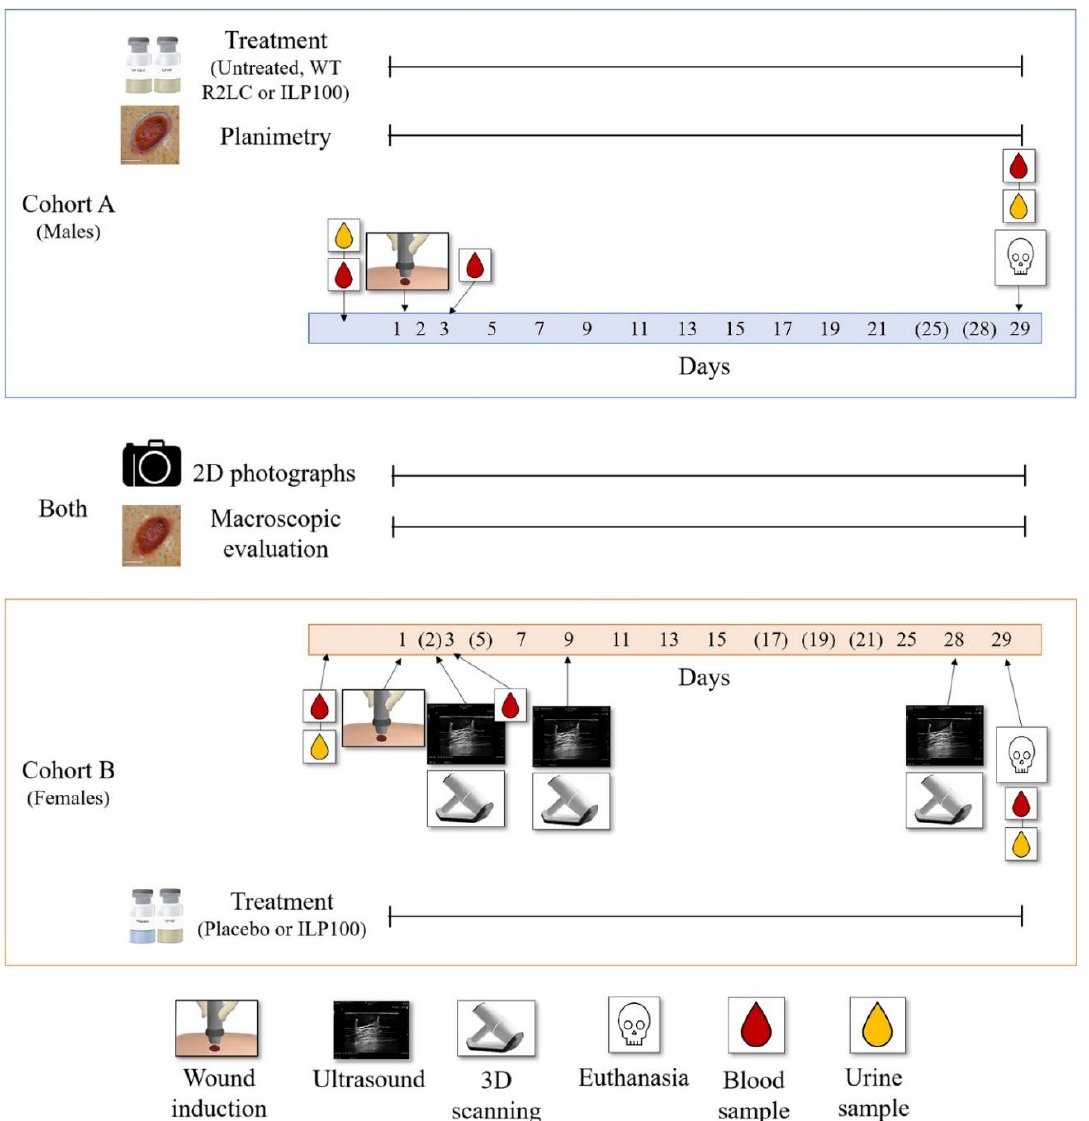
Figure 1. Schematic illustration of the protocol design. The study consists of two cohorts: one in males (Cohort A, blue box) and one in females (Cohort B, orange box). In the illustration, the numbers in the filled blue (Cohort A) and orange (Cohort B) boxes indicate the days where 2D photographs, macroscopic evaluation, treatment, and planimetry (only Cohort A) were performed. No 2D photographs, macroscopic evaluation, or planimetry were performed on the days in parenthesis. Time points for wound induction, collection of blood (for hematology, clinical chemistry, plasma levels of CXCL12 and SppIP, and for CFU counts of ILP100), collection of urine samples, and for additional imaging (only Cohort B) with ultrasound and 3D scanning are indicated with arrowed symbols.